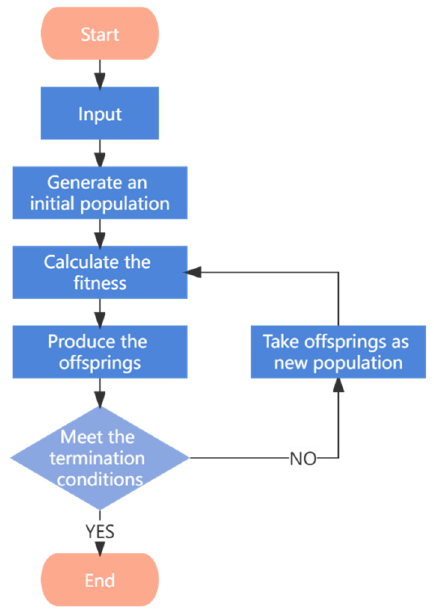
Figure 3. The proposed GP flow chart.